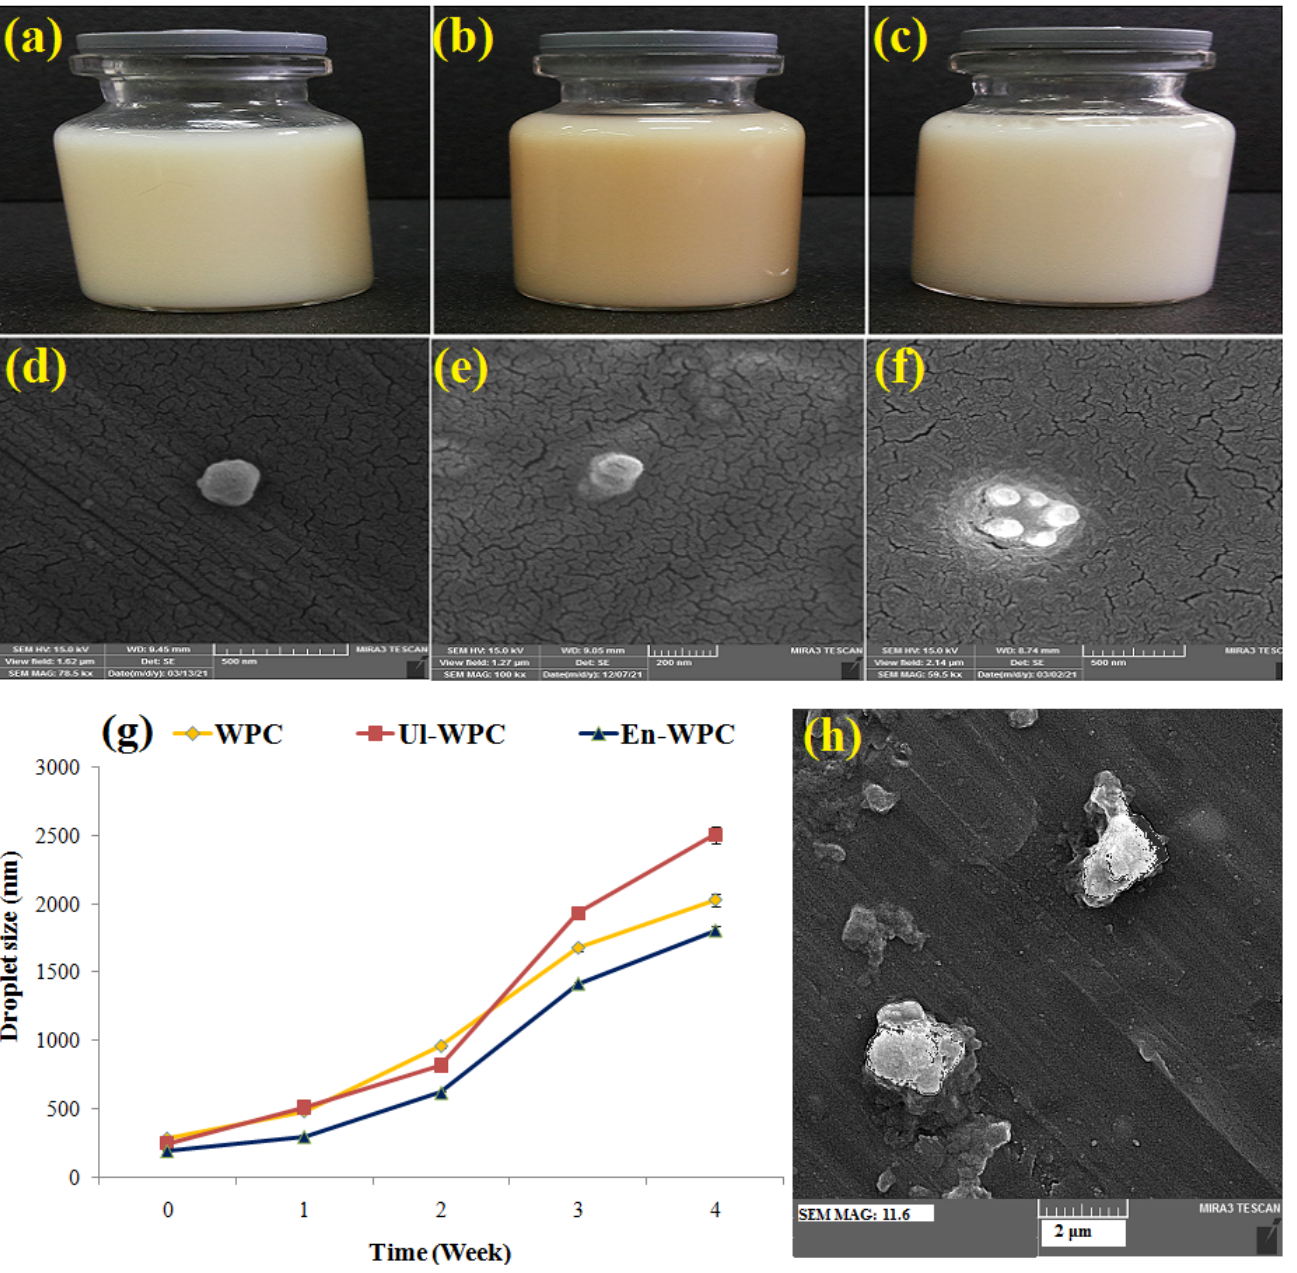
Figure 4. Optical ( a – c ) and SEM ( d – f , h ) images, and droplet size vs. storage time plot ( g ) related to grape seed oil emulsions stabilized with Ul30-WPC ( a , d , h ), intact-WPC (( b , e ), and En30-WPC ( c , f ).